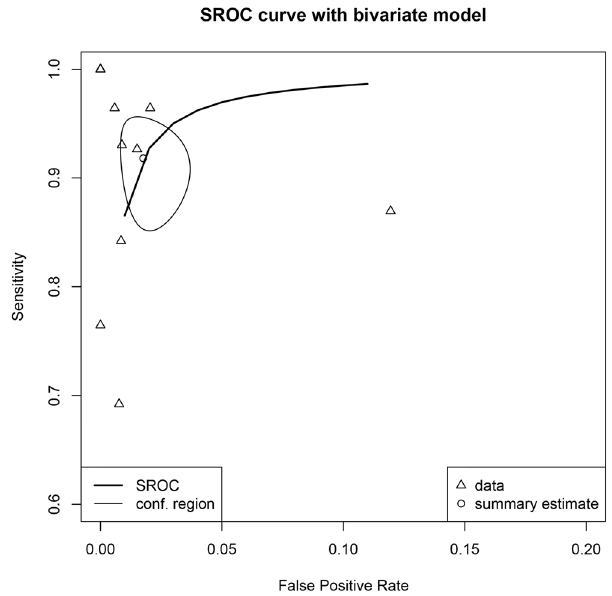
Figure 3. Summary receiver operating characteristic (SROC) curve plotting sensitivity against false positive rate (1-specificity). The summary estimate was calculated using bivariate approach. The result showed that the CEUS had a sensitivity of 0.981 (95% CI: 0.868–0.950) and a false positive rate of 0.018 (95% CI: 0.010–0.032) for identifying parenchymal injuries.